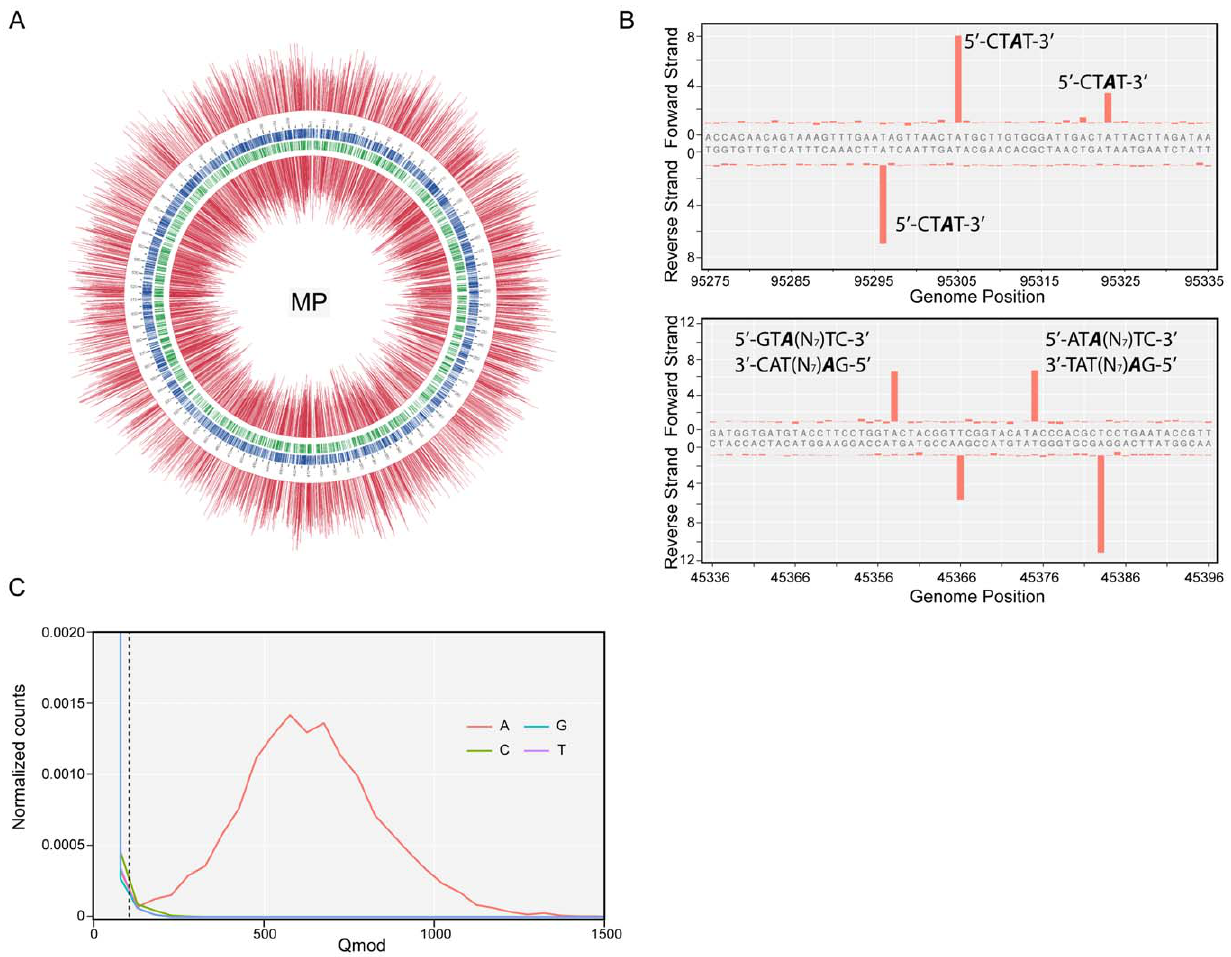
Figure 1. Methylome determination of M.pneumoniae by SMRT sequencing. ( A ) Circos plot of kinetic variation across the genome. Red tracks represent the Qmod ( 2 10log( P value) from t-test) values of the forward (outer track) and reverse (inner track) strands. Blue and green tracks represent the location of the 5 9 -CT A T-3 9 and Type I motifs discovered by filtering on Qmod values as shown in ( C ). ( B ) Example of IPD ratio plots of the two discovered motifs for a section of the genome. The top plot shows 3 instances of 5 9 -CT A T-3 9 , two of them are asymmetrically methylated. The bottom plot shows 2 Type I examples, where each one is fully methylated; that is each Type I recognition site is methylated on both strands. ( C ) Qmod distribution showing the filtering threshold of 100 used (black dash line) for determining modified positions.